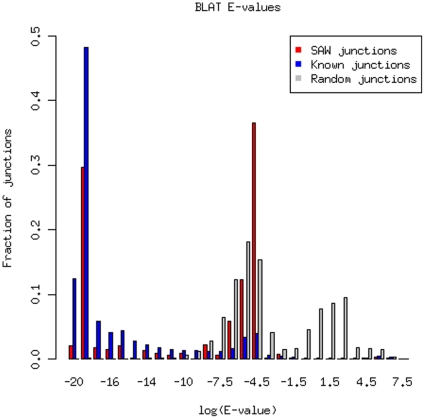
The BLAT E-value distribution of 48mers that spanning known junctions, random junctions and junctions identified by SAW.